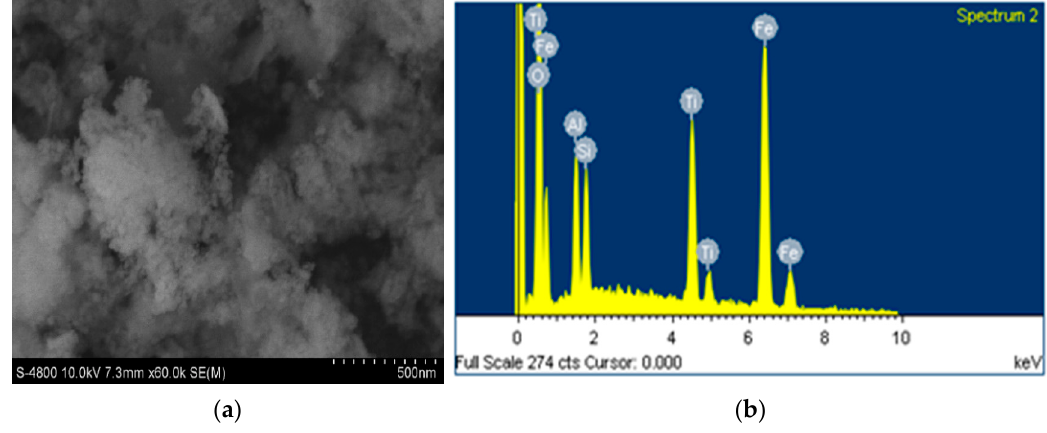
Figure 6. ( a ) SEM; ( b ) EDX of Red Sluge samples after treatment. Table 1. Treatment efficiency of domestic wastewater treatment using constructed wetland combined with sludge adsorption.